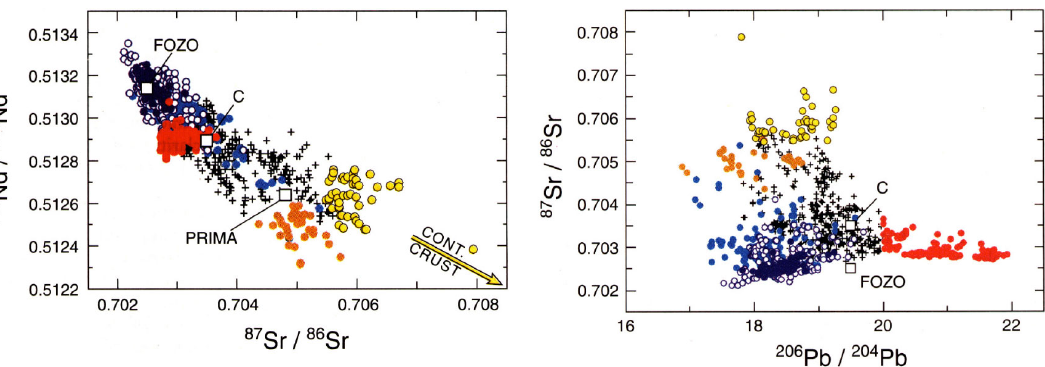
Fig. 5. Observed Nd and Sr isotopic heterogeneity of mantle-derived rocks. Legend and acronyms as in Fig. 2. From Hofmann (1997). Reprinted from Nature with permission. Copyright Macmillan Magazines Ltd.